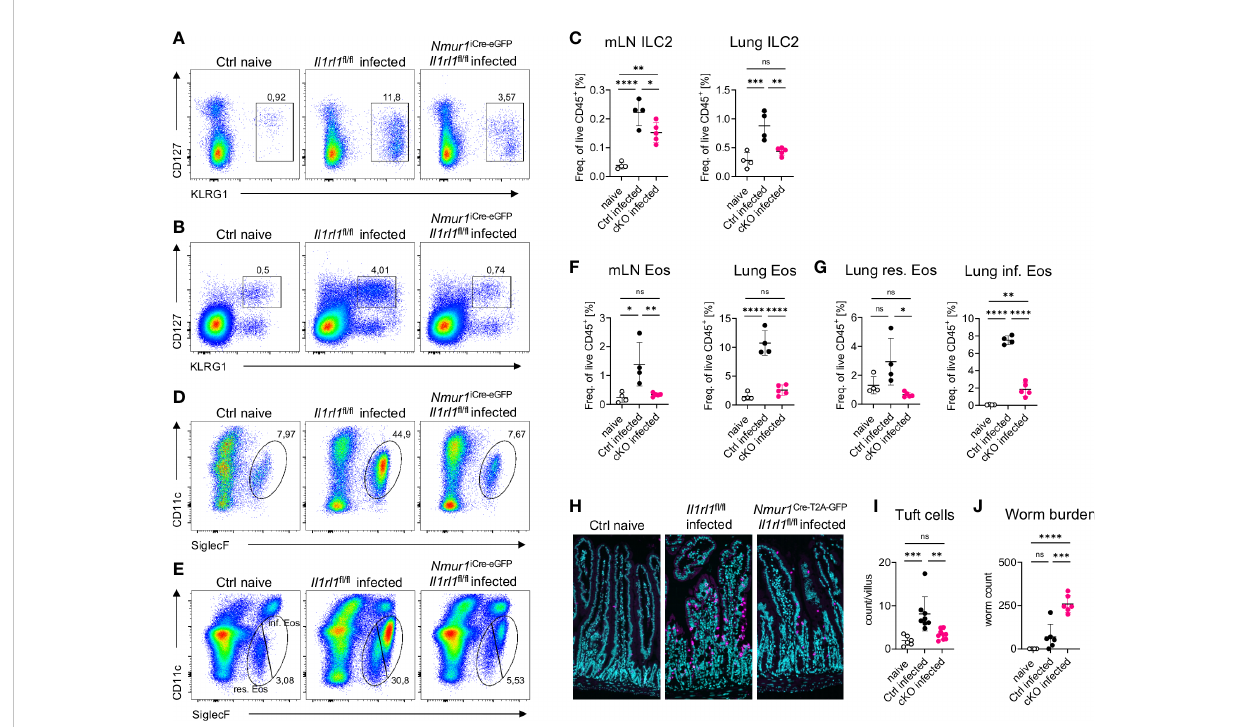
FIGURE 6 ILC2 intrinsic ST2 is required for immunity against N. brasiliensis infection. (A, B) , Flow-cytometric plots showing ILC2s in the mLN (A) and in the lung (B) of untreated Ctrl (naïve) animals and infected Nmur1 iCre-eGFP Il1rl1 fl ox/ fl ox mice (cKO) and littermate controls (Ctrl). Mice were infected with N. brasiliensis . (C) , Quanti fi cation of (A, B) . (D, E) Flow-cytometric plots showing eosinophils in the mLN (D) and in the lung (E) of untreated Ctrl (naïve) animals and infected Nmur1 iCre-eGFP Il1rl1 fl ox/ fl ox mice (cKO) and littermate controls (Ctrl). Mice were infected with N. brasiliensis . (F) , Quanti fi cation of (D) and (E, G) , Quanti fi cation of relative resident and in fl ammatory eosinophil numbers in the lung of untreated Ctrl (naïve) animals and infected Nmur1 iCre-eGFP Il1rl1 fl ox/ fl ox mice (cKO) and littermate controls (Ctrl). (H) , Immuno fl uorescence migrographs of histological sections of the murine small intestine, tuft cells stained with DCLK1 (magenta), DAPI (blue). (I) , Quanti fi cation of (H) . Tuft cell numbers per villus. Data combined from two independent experiments. (J) , Worm burden in untreated animals (naïve) and infected Nmur1 iCre-eGFP Il1rl1 fl ox/ fl ox mice (cKO) or littermate controls (Ctrl). For (C, F, G, I, J) : Data are representative of two experiments with four to six mice per group. One-way ANOVA with multiple comparisons, ns, not signi fi cant, *p < 0.05, **p < 0.01, ***p < 0.001, ****p <